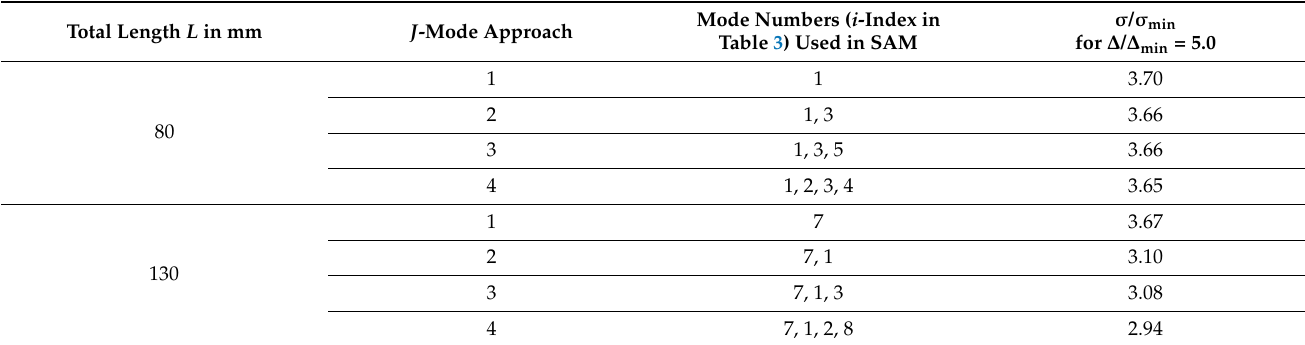
Table 4. Dimensionless overload coefficient σ / σ min as a function of the dimensionless shortening ∆ / ∆ min = 5.0 for TH-columns (ANM results).